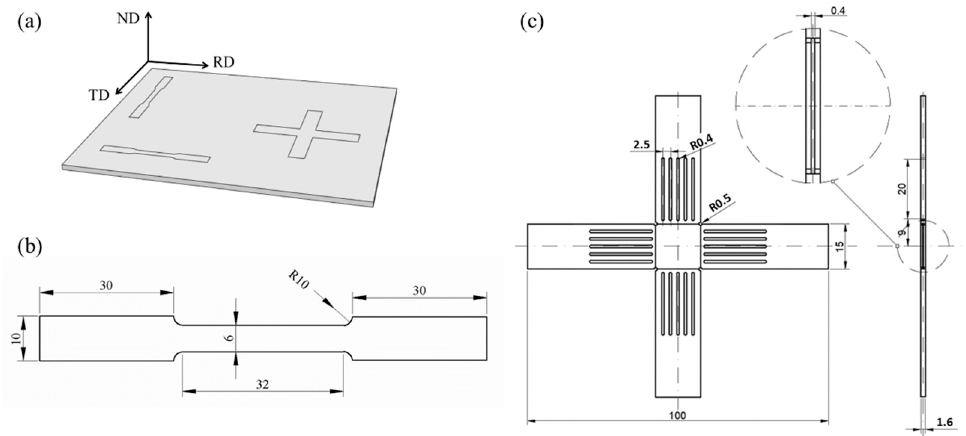
Figure 1. ( a ) Schematic of specimen orientation and dimensions of ( b ) uniaxial and ( c ) biaxial tensile specimen (unit: mm).